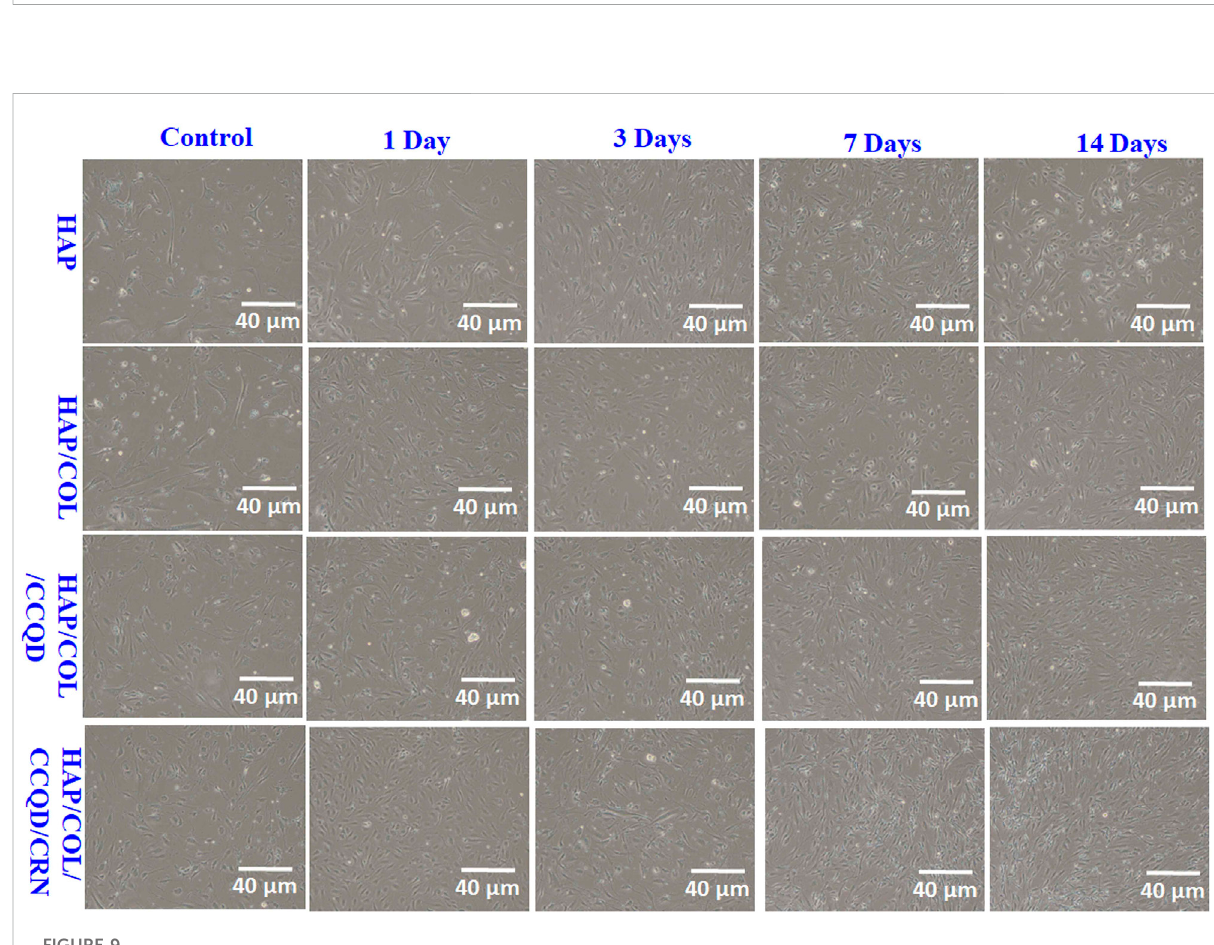
FIGURE 9 Optical microscopic images of hBMSCs after being treated with prepared composites at different treatment days.